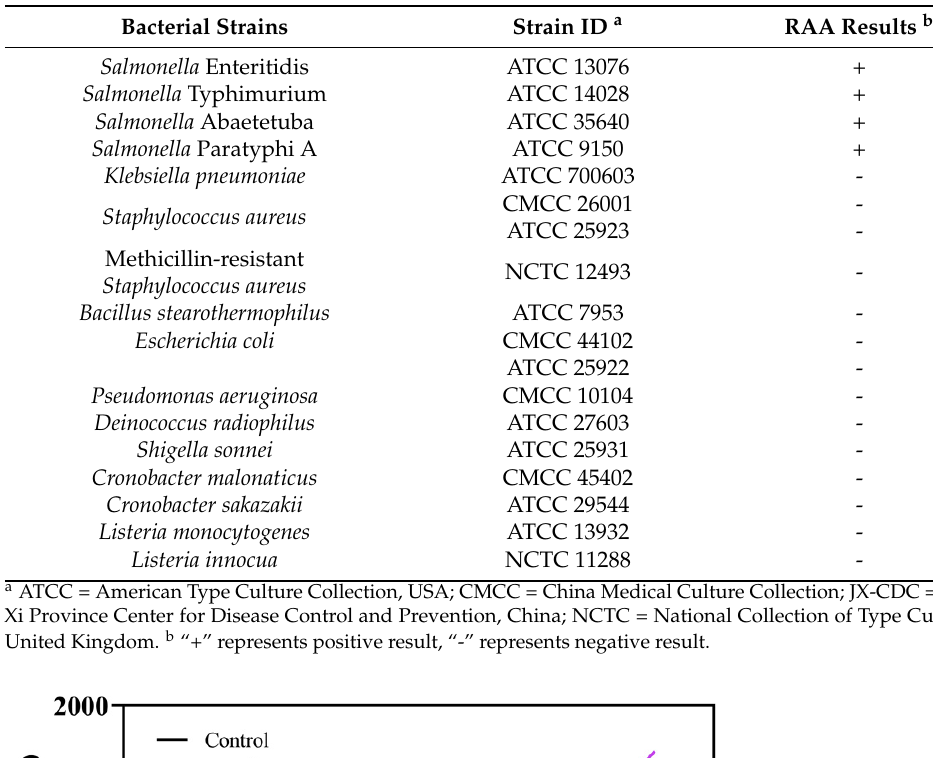
Table 2. Bacterial strains used in this study and the results of the RAA assay.